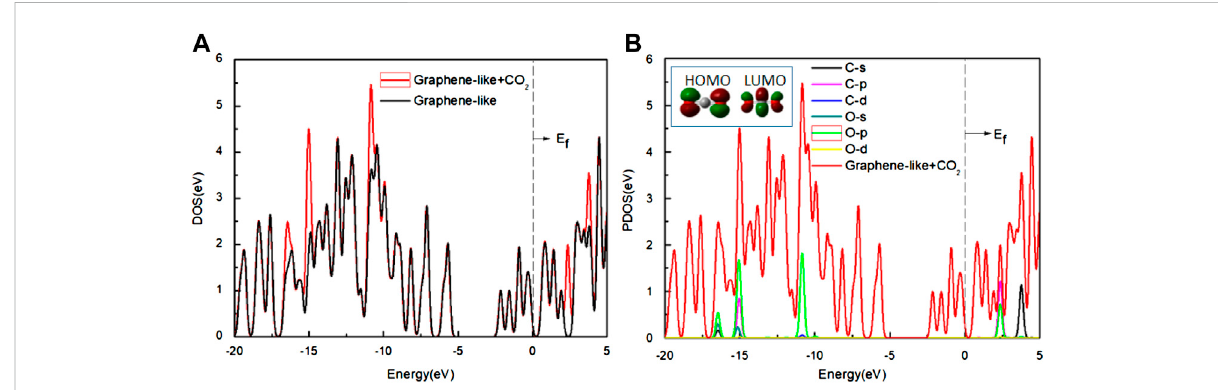
FIGURE 8 (A) The DOS of the graphene-like surface before and after the adsorption of CO 2 ; (B) The PDOS of the CO 2 on the surface. Inset: HOMO and LUMO of CO 2 (green and deep red lines indicate different signs of the orbital wavefunctions). Main panel: The red line is the DOS of CO 2 on the graphene-like surface, other lines show the PDOS of the various orbits of the C and O atoms, respectively.